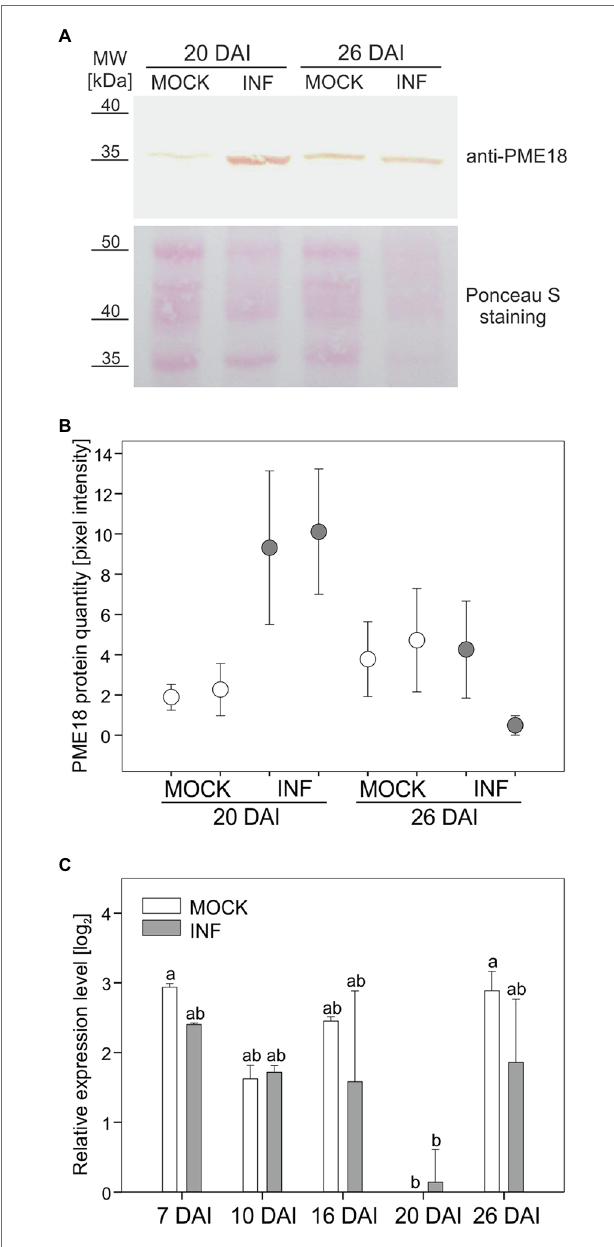
FIGURE 2 | Pectin methylesterase (PME18) protein is differentially accumulated after infection with P. brassicae. (A) Western blot assay showing PME18 protein levels in the cell wall fraction from hypocotyls of mock-treated and P. brassicae- infected plants 20 DAI and 26 DAI. Total protein loading (10 μ g) is depicted with Ponceau S PVDF membrane staining. (B) PME18 protein quantity measured as pixel intensity (mean gray value) of the Western blot bands. For each combination, two independent biological experiments (90 plants per sample) are plotted as two separate data points representing the mean of three technical replicates ± SD. (C) qRT-PCR analysis of PME18 gene expression in the roots of mock-inoculated and P. brassicae- infected Col-0 Arabidopsis plants at indicated times (DAI). Transcript levels were normalized to two reference genes ( TIP41 and UBC9 ), calculated relative to the expression in mock-treated plants at 20 DAI and plotted as the means of three independent biological experiments (each with 30 plants per treatment) ± SE. Different letters indicate a significant difference between means (Tukey’s test, p <